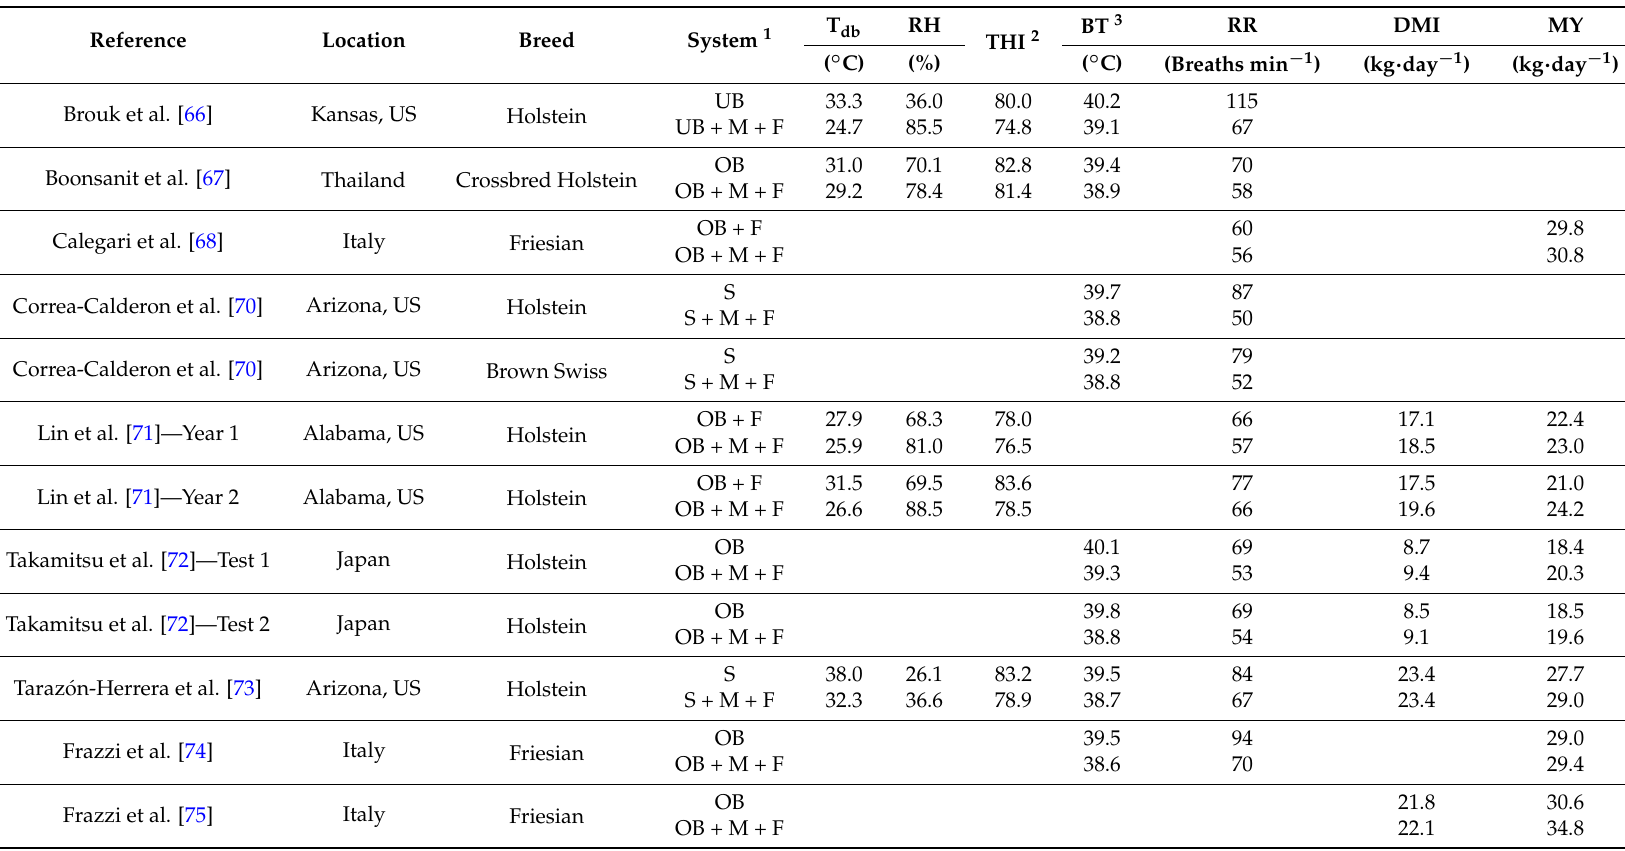
Table 6. Meteorological attributes, THI calculations, and physiological response of dairy cows for control treatments and barns equipped with mist-fan